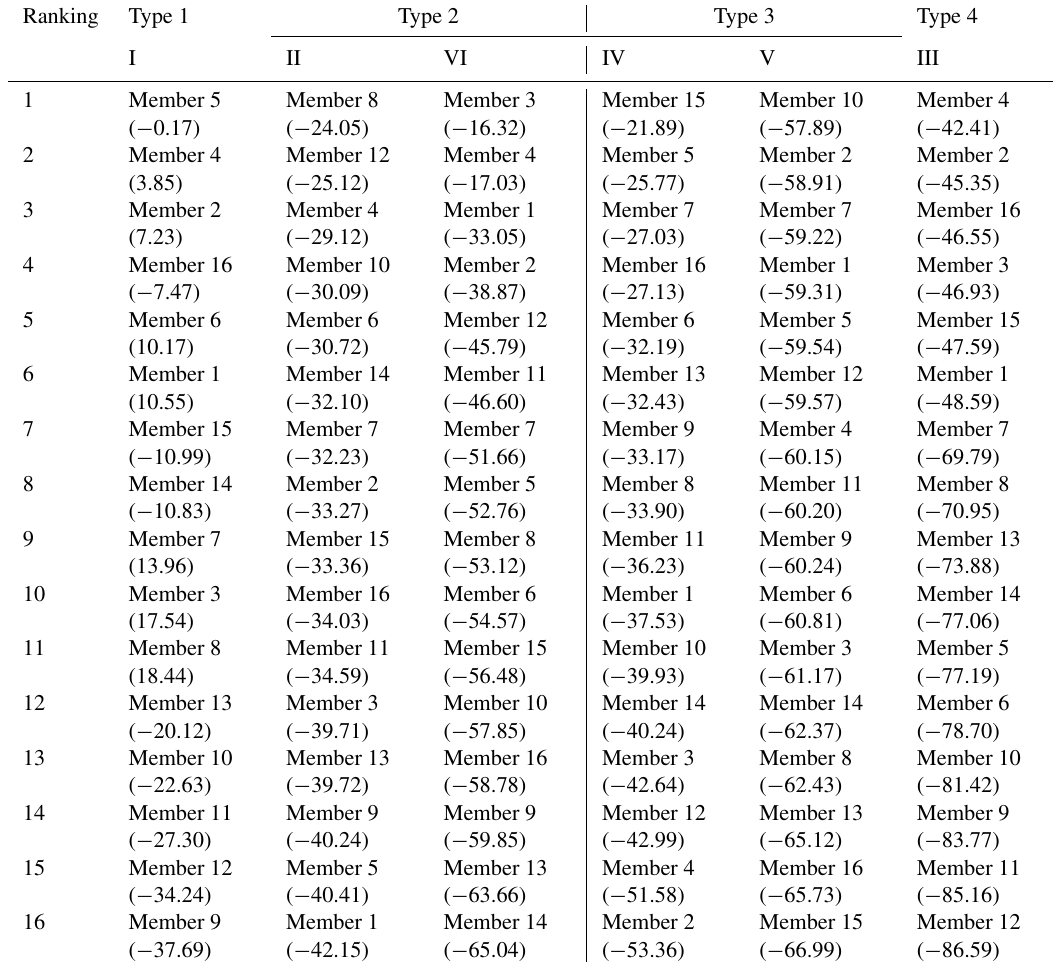
Table 5. Rankings of the 16 members of the physical ensemble according to RE (%) of the simulated rainfall accumulations for the storm events.